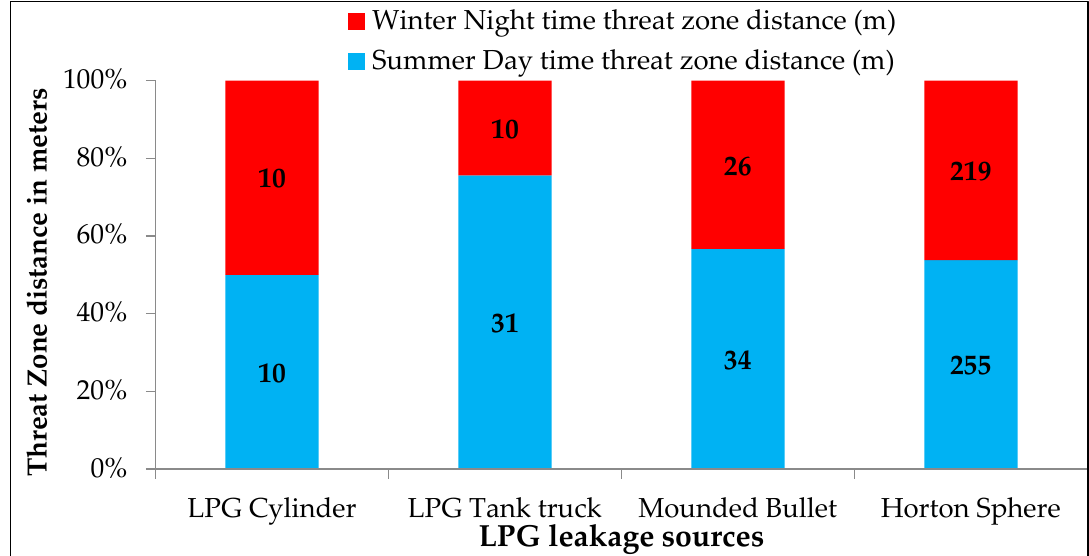
Figure 7. Fireball radiations of 37.5 kW/m 2 .